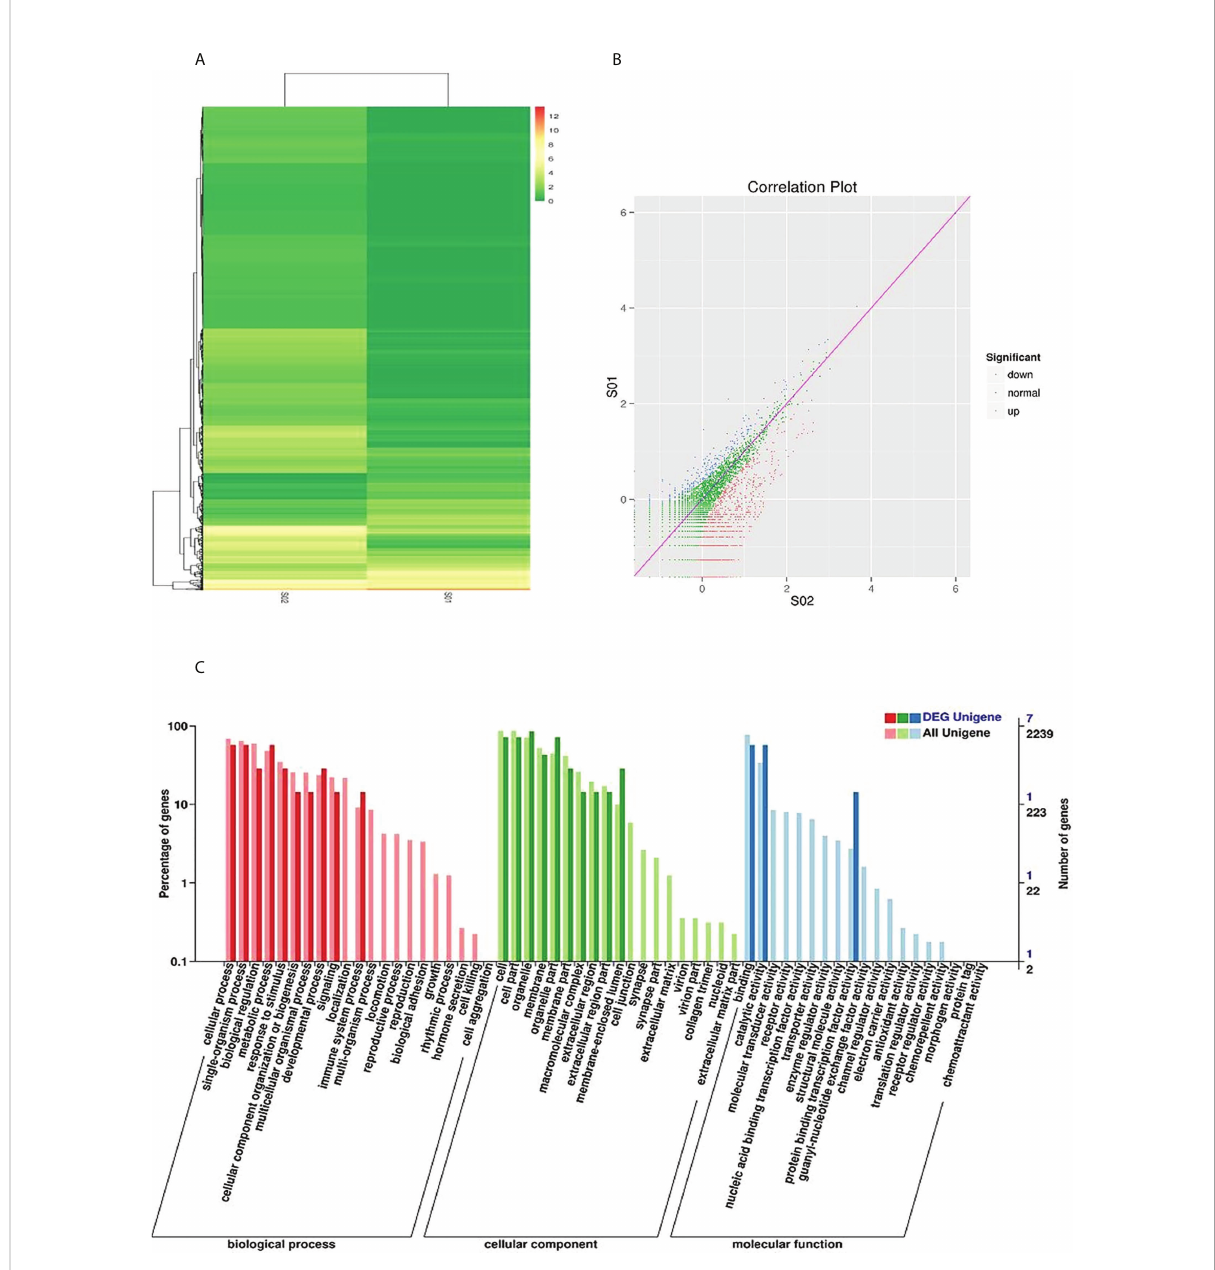
FIGURE 1 Sequencing analysis of piRNAs in cancerous and adjacent noncancerous tissues of NSCLC. (A) Hierarchical cluster and (B) Correlation Plot analysis of differential piRNAs betweencarcinoma tissues and para-carcinoma tissues of NSCLC patients (C) GO analysis (SOl, para-carcinoma tissues; SO2, carcinoma